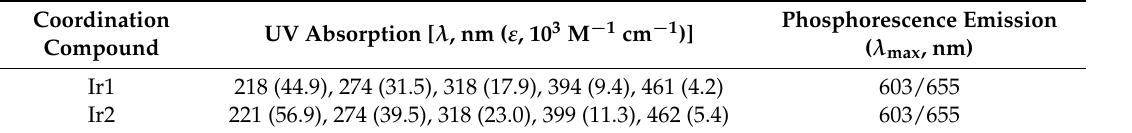
Table 2. UV-Vis absorption spectra and phosphorescence emission spectra of coordination compounds Ir1 and Ir2.